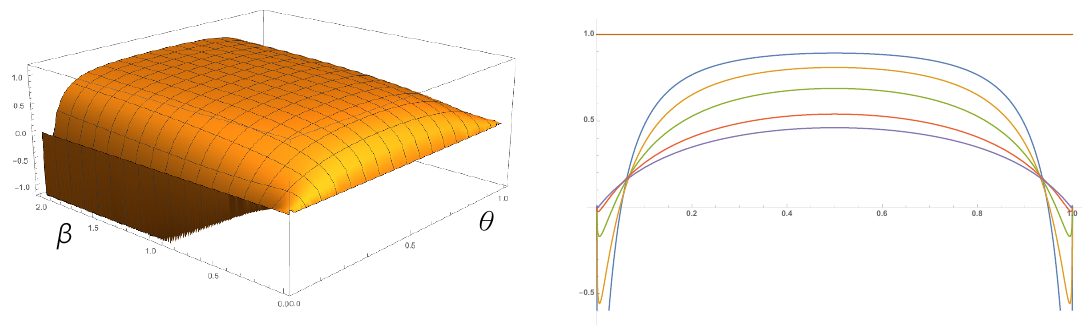
Figure 16 . To the left is a plot of the ratio (5.40) for (cid:15) = 0 : 1 as a function of (cid:12) 2 [0 ; 2] and (cid:18) 2 [0 ; 1]. In the middle we see a \plateau", towards (cid:18) = 0 ; 1 \trenches", and towards (cid:12) = 0 a \cli(cid:11)". To the right are cross sections of this plot for (cid:18) 2 [0 ; 1] and (cid:12) = 1 ; 0 : 5 ; 0 : 25 ; 0 : 125 and 0 : 0875. the transition from the plateau towards (cid:12) = 0. Similar qualitative analysis applies to other contributions to the Ellwood invariant, so we will obtain the physically expected value in the (cid:15) ! 0